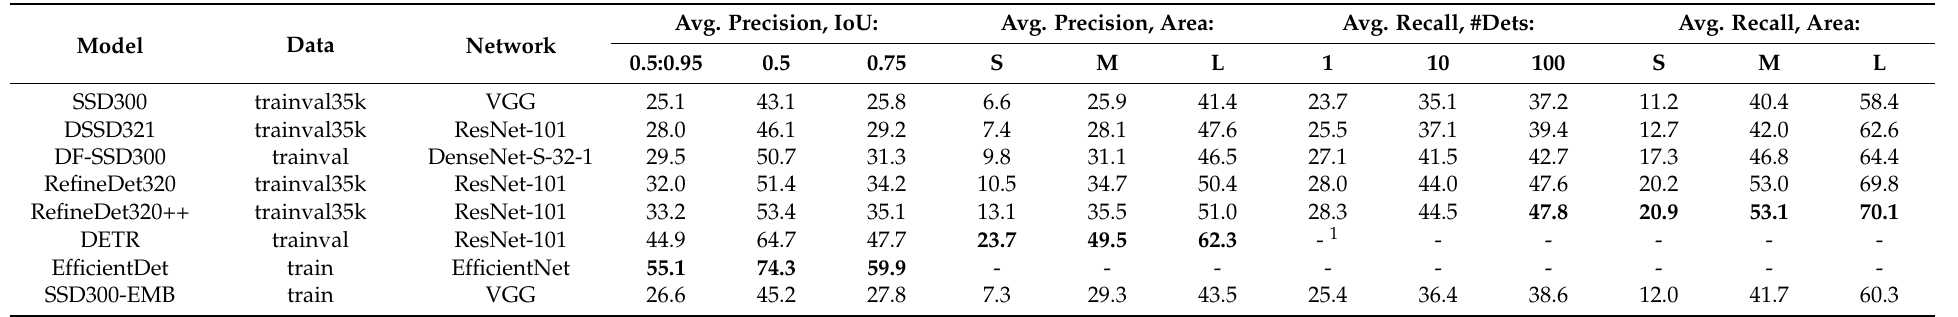
Table 4. Average precision (in %) for our method and others on MS COCO test-dev 2015. Bold indicates the highest value for each column. Avg. Precision, IoU corresponds to the average APs for IoU (0.5~0.95, 0.5, 0.75). AP@[0.5:0.95] is performed with a step size of 0.05. Avg. Precision, Area means the average APs for the object area size (S, M, L). Avg. Recall, #Dets means the average ARs for the number of detections (1, 10, 100). Avg. Recall, Area indicates the average ARs for the object area size (S, M,